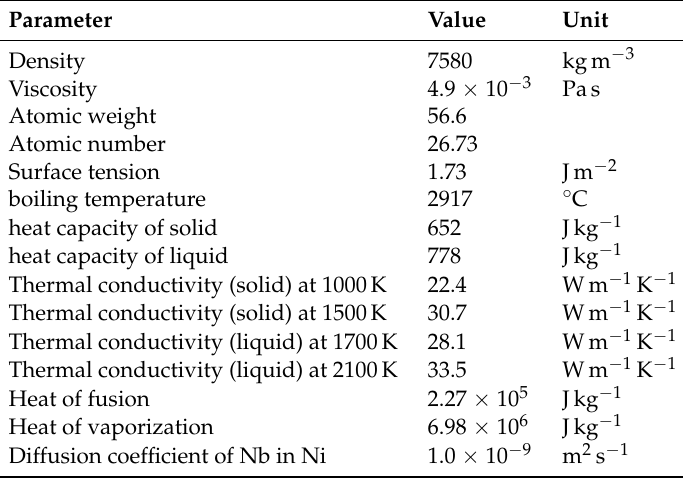
Table 3. Material parameters for simulations